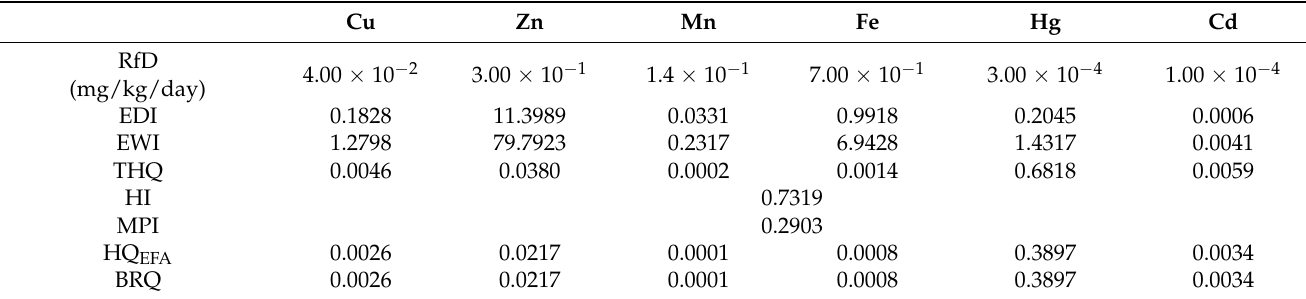
Table 2. The hazard quotient calculated for metal content in the muscle tissue of